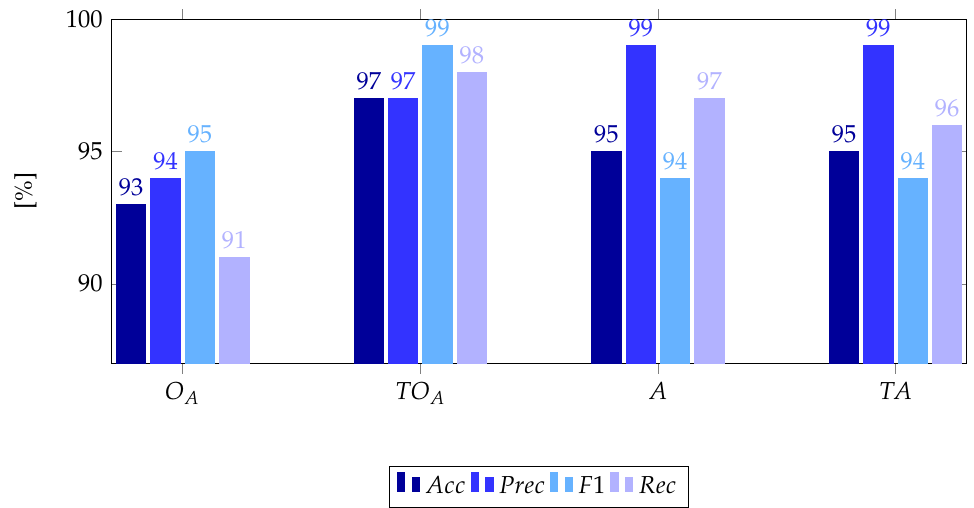
Figure 7. Performances of OCCNN and ANN reference models with ( TO , TA ) and without ( O A , A 1 ) temperature input values, for compression-free